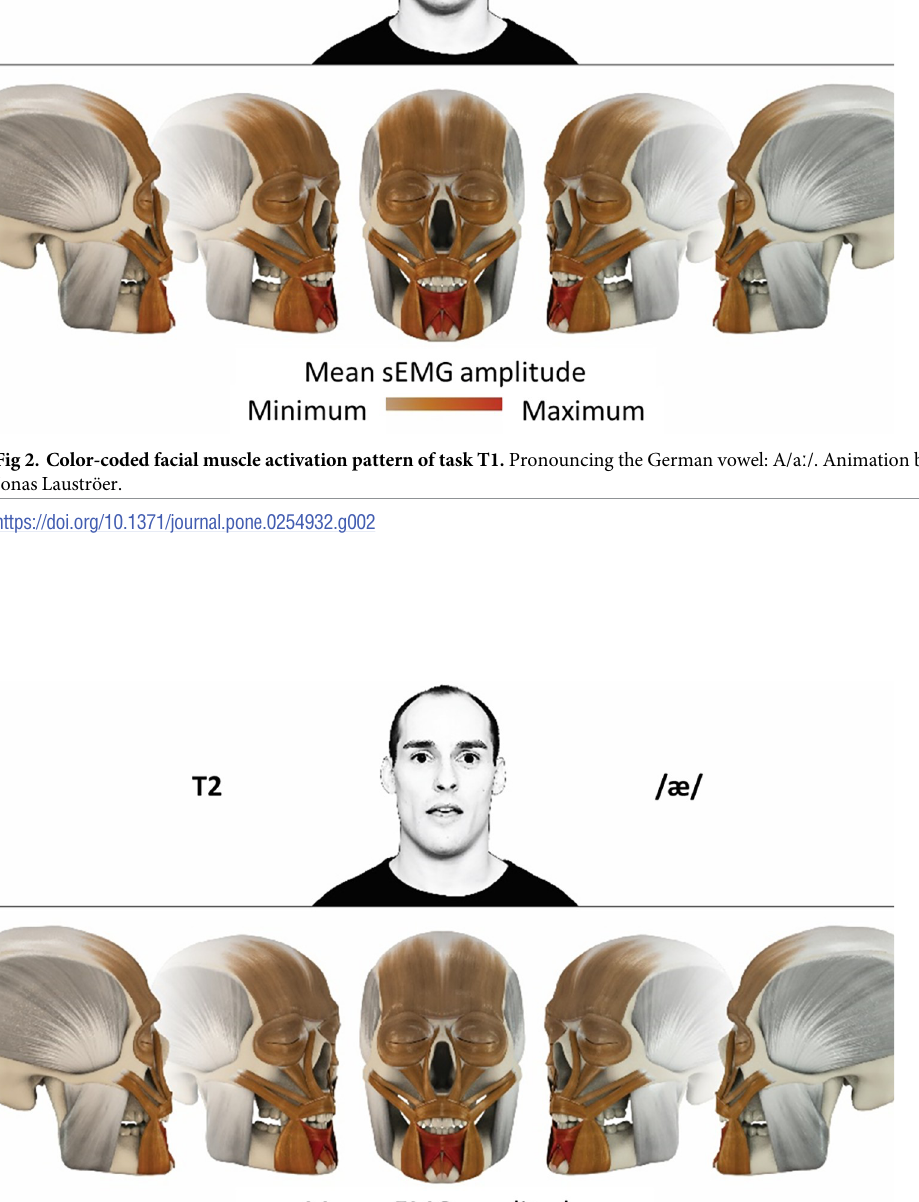
PLOS ONE | https://doi.org/10.1371/journal.pone.0254932 July 19,